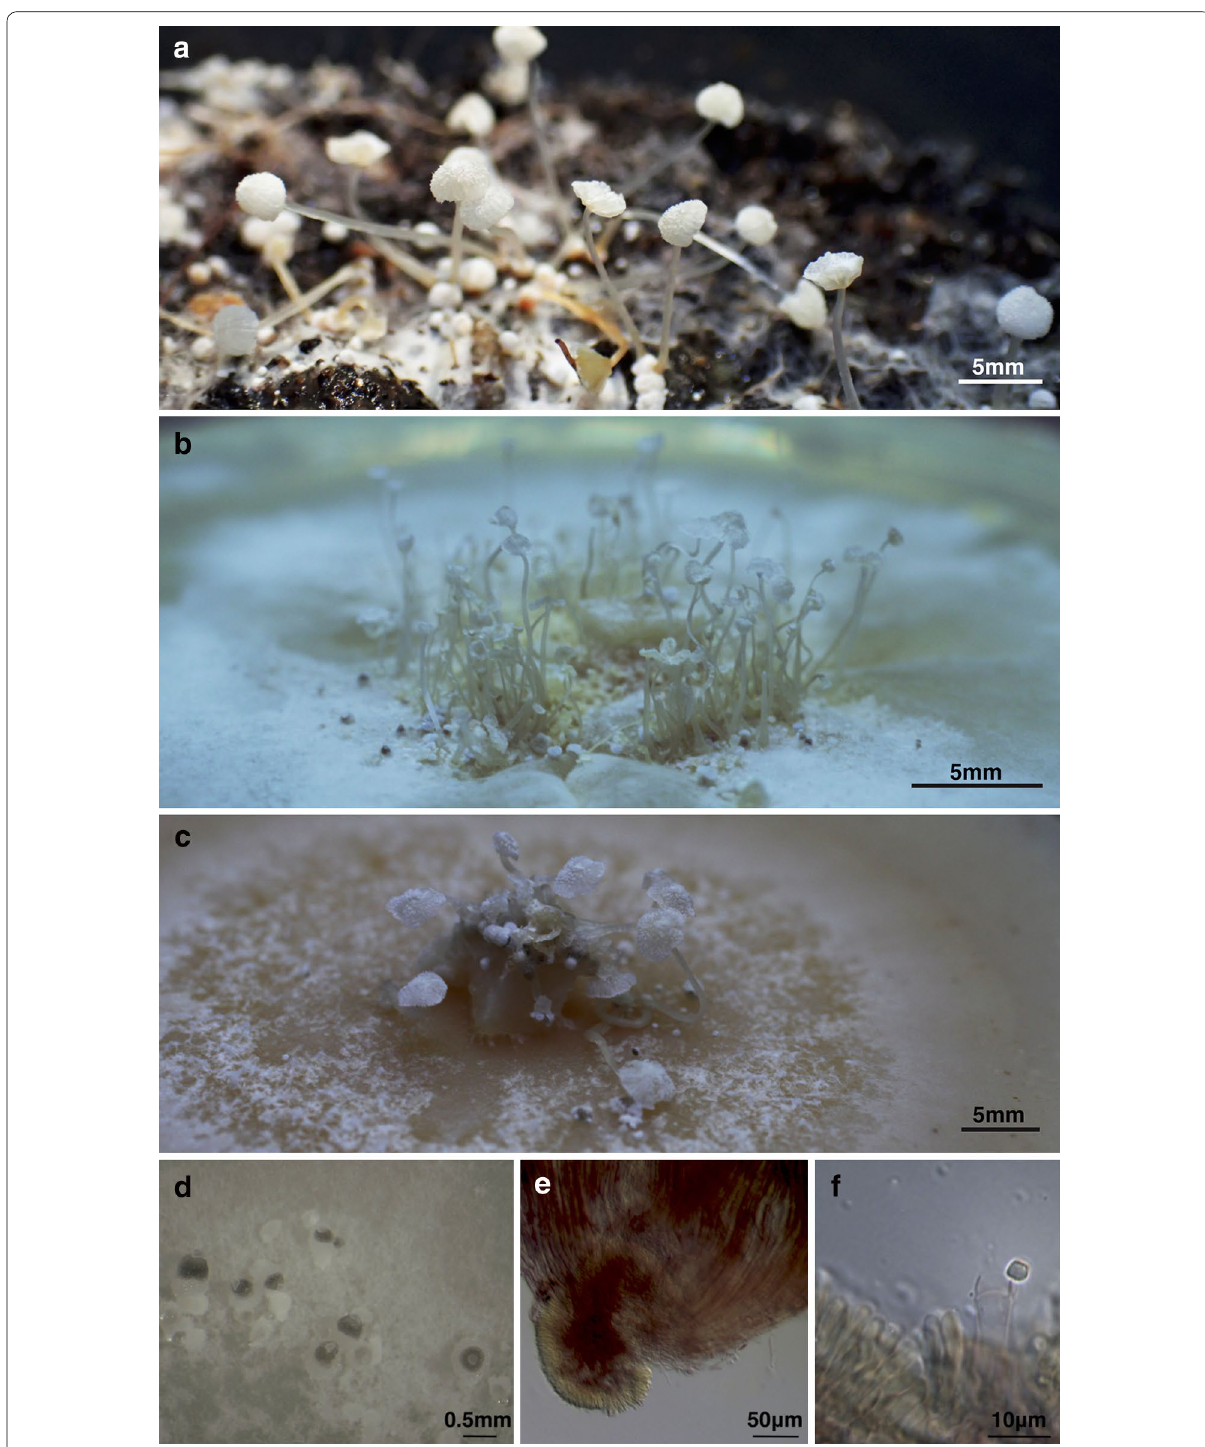
Fig. 3 Basidiomata production of Mycena albopilosa . a–c On commercial soil and black rice bran of 4:1 ratio, PDA, and OA, respectively. d Partially developed basidiomata on PDA. e, f Basidia and basidiospores produced on partially developed